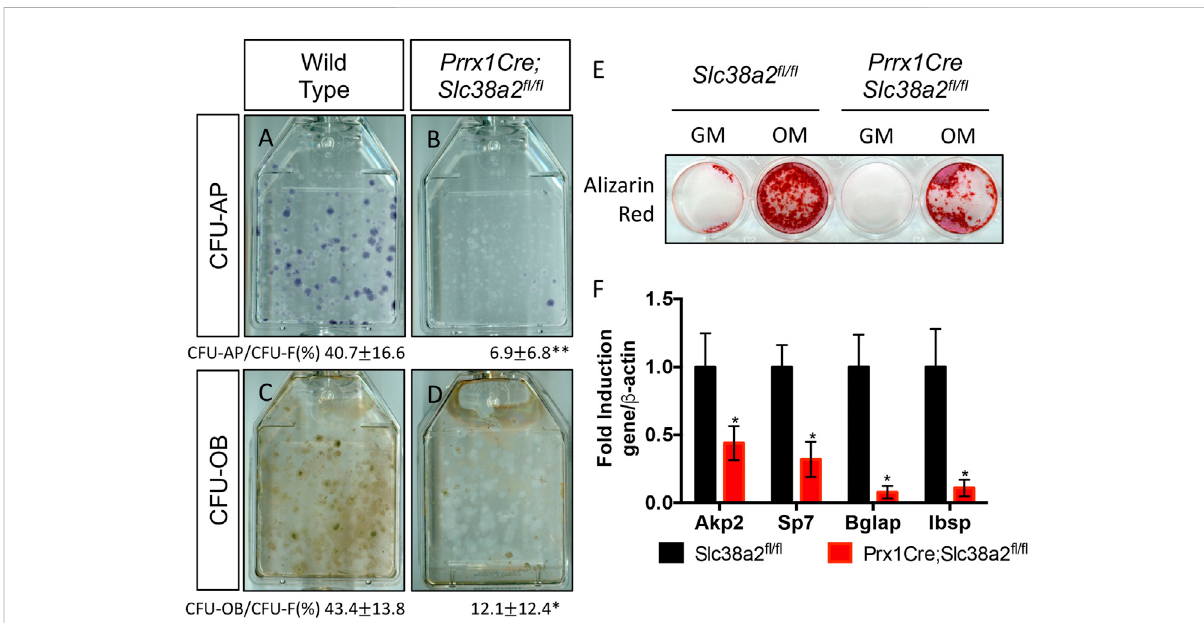
FIGURE 7 SLC38A2ablationreducesosteogenicdifferentiationandmatrixmineralization invitro . (A – D) RepresentativeimagesofCFUassaysstainedwith alkaline phosphatase (CFU-AP) or von kossa (CFU-OB) from wild type (A,C) or Prrx1Cre;Slc38a2 fl / fl mice (B,D) . Quanti fi cation of the proportion of colonies containing at least 20 stained cells divided by the total number of colonies (CFU-F, from Figure 5) shown below each panel. * p < 0.05, n = 5 mice each genotype. (E – F) Evaluation of osteoblast differentiation in primary BMSC as measured by Alizarin red staining (E) or osteogenic gene expression (F) measured by RT-qPCR. BMSC were cultured in growth media (GM) or osteogenic media (OM). Gene expression normalized to Actb ( β -actin) mRNA levels. * p < 0.05. N = 3 individual